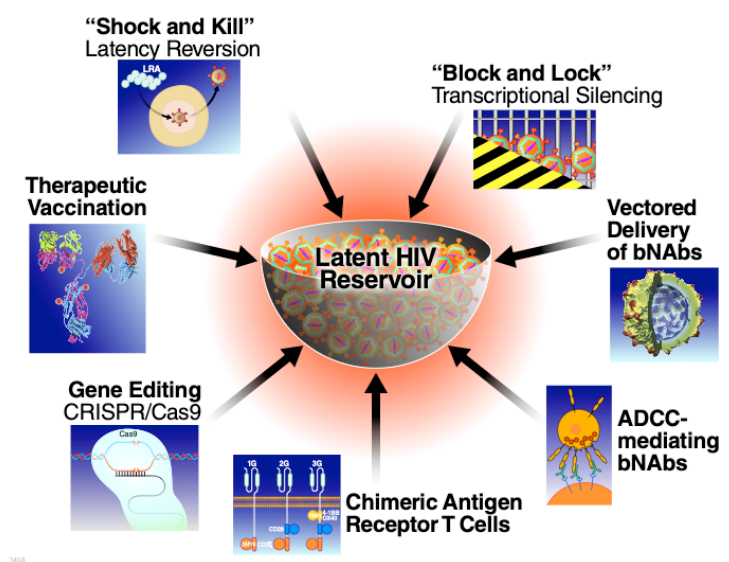
Figure 1. Therapeutic approaches being explored aimed at long term neutralization of the latent HIV reservoir. (bNAbs, broadly neutralizing HIV antibodies; ADCC, antibody dependent cellular cytotoxicity).